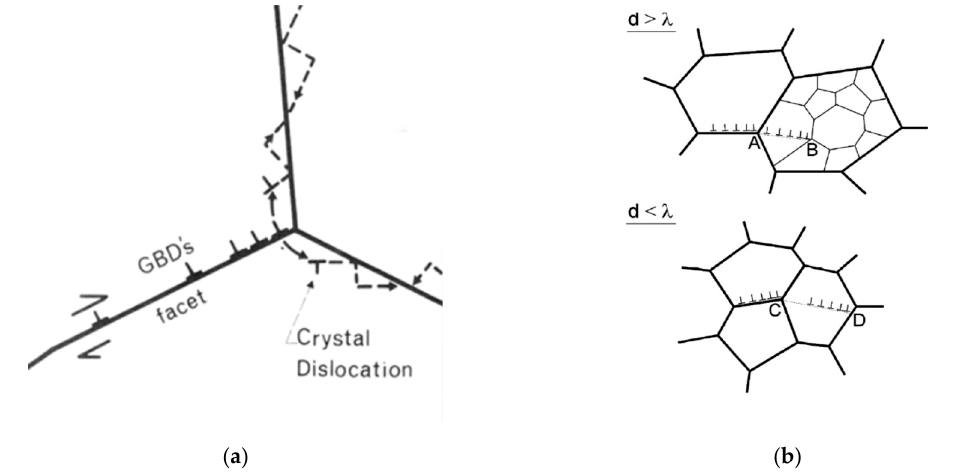
Figure 16. ( a ) GBS and its accommodation proposed by Gifkins [139]. ( b ) A unified model for Rachinger GBS originated by Langdon [141].